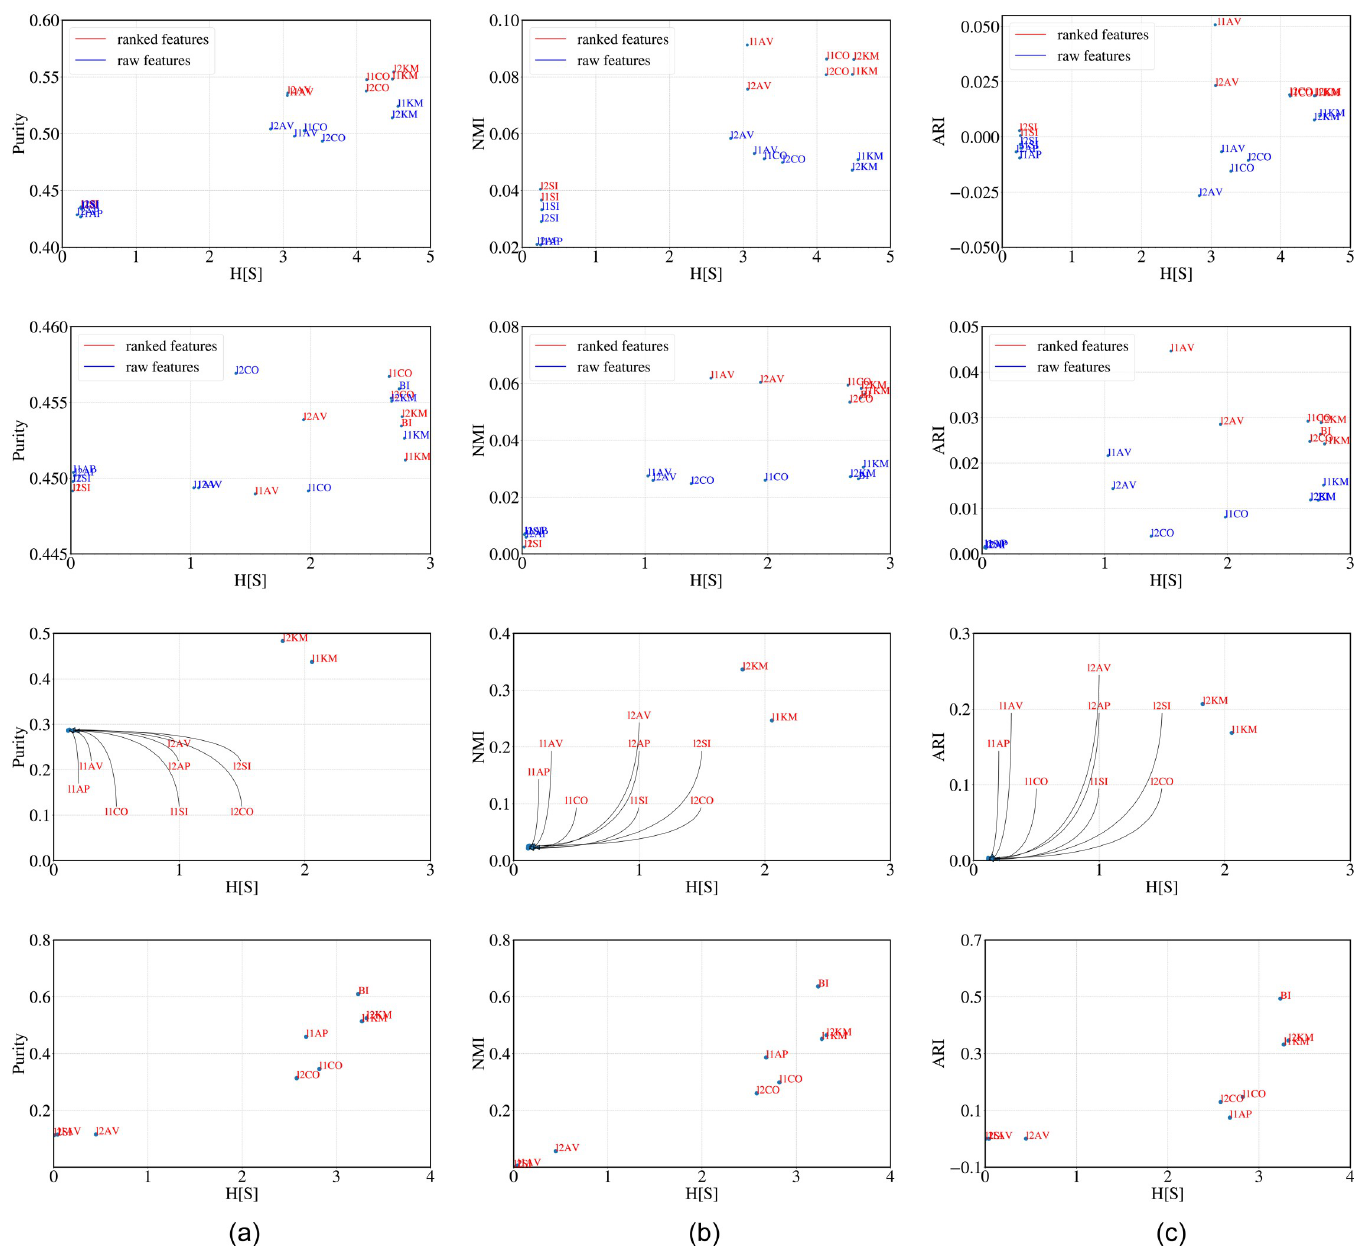
Fig 4. H[S] versus purity, NMI and ARI for (i) red wine, (ii) white wine, (iii) TREC and (iv) MNIST datasets (from top to bottom). Note that for the wine datasets we considered two types of feature matrices. For raw features (represented in blue) we considered the values of the features as provided in the dataset to obtain the feature vector of each point while for ‘ranked feature” (represented in red) we rank each feature based on the value and then use this rank score instead of the raw